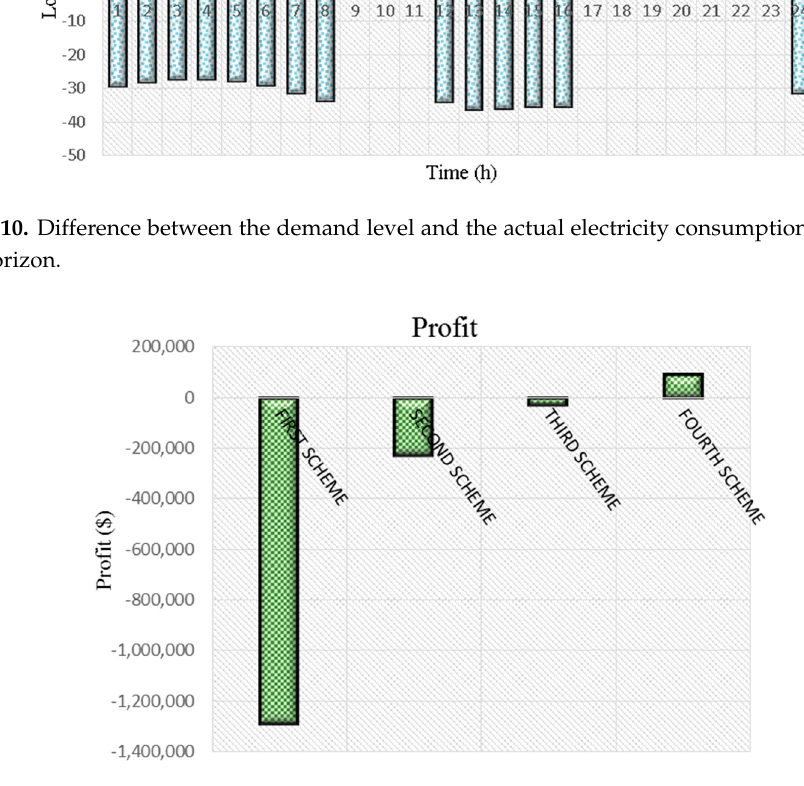
Figure 11. Retailer’ profit under different schemes with the average selling price of 63 $/MWh.